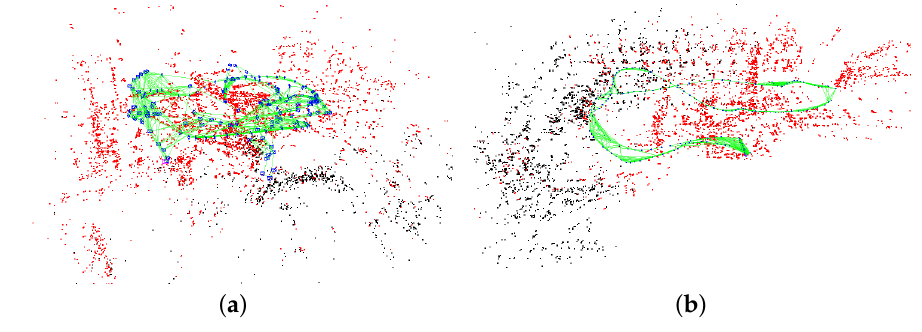
Figure 9. The reconstructed sparse map of ( a ) the Vicon room and ( b ) the machine hall.